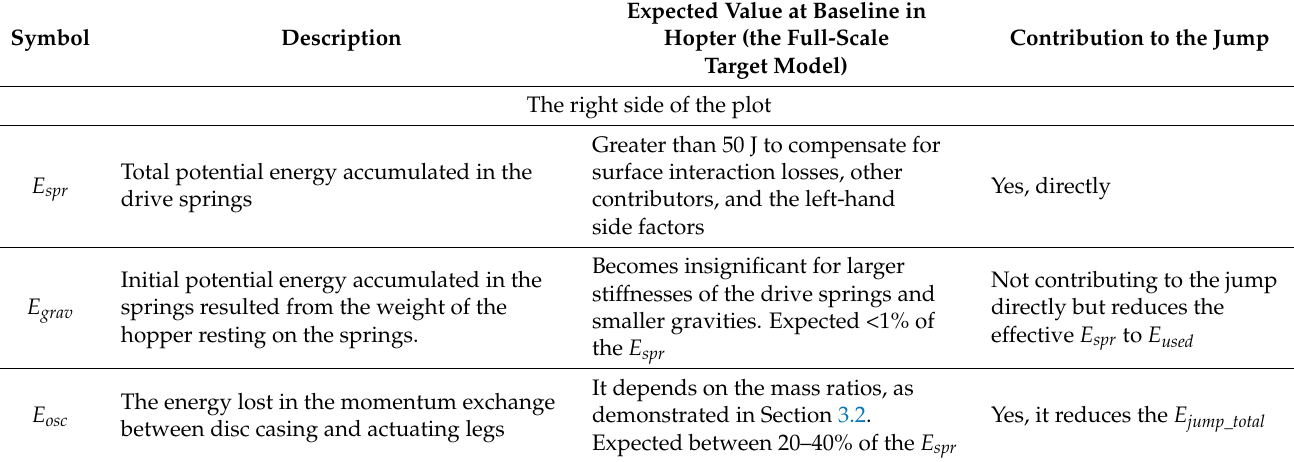
Table 1. Description of the energy